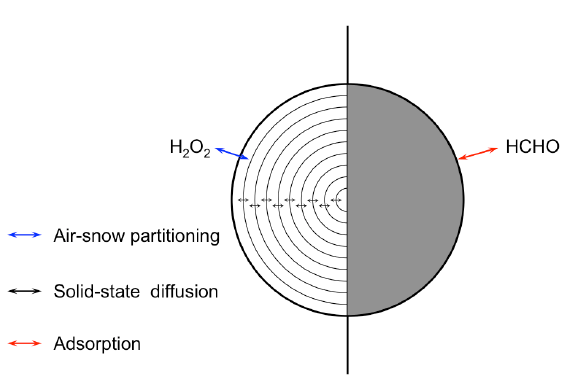
Fig. 14. Scheme illustrating two approaches to parameterise the ex- change of impurities between the snow grains and the adjacent inter- stitial air: a transport model using spherical layers (H 2 O 2 , left side). A bulk approach assuming that an uptake equilibrium between the entire ice phase and the air is established (formaldehyde, right